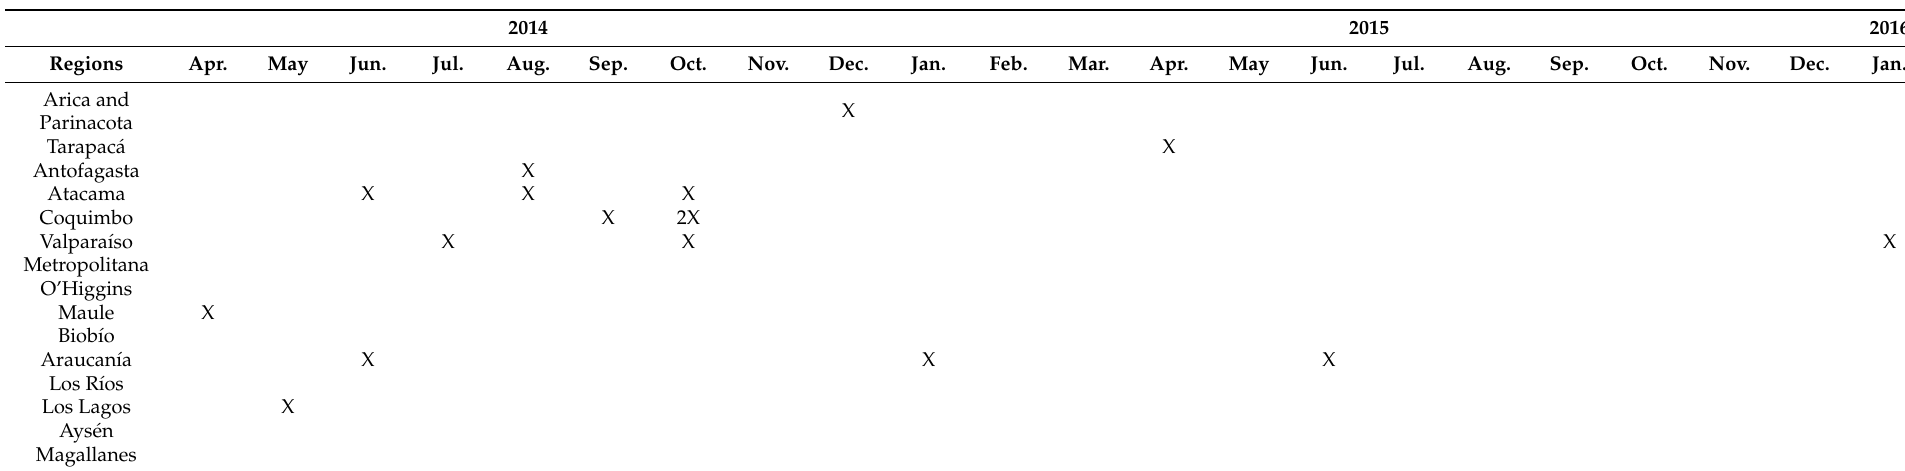
Table 2. Workshops according to date informed by